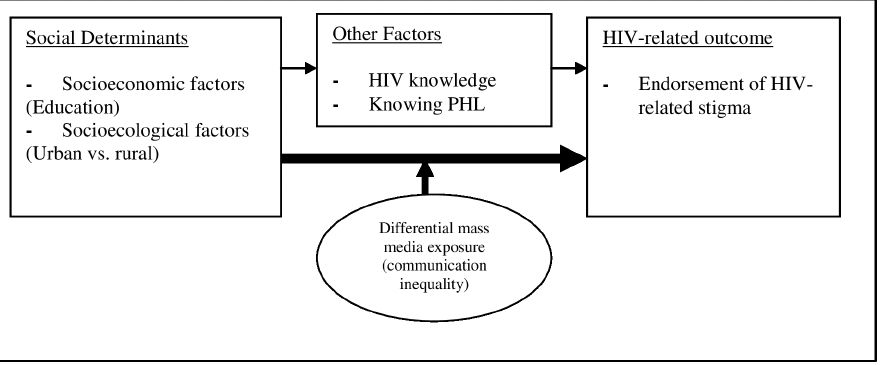
Figure 1. Conceptual framework of the study (adapted from the structural influence model, Viswanath et al., 2007).